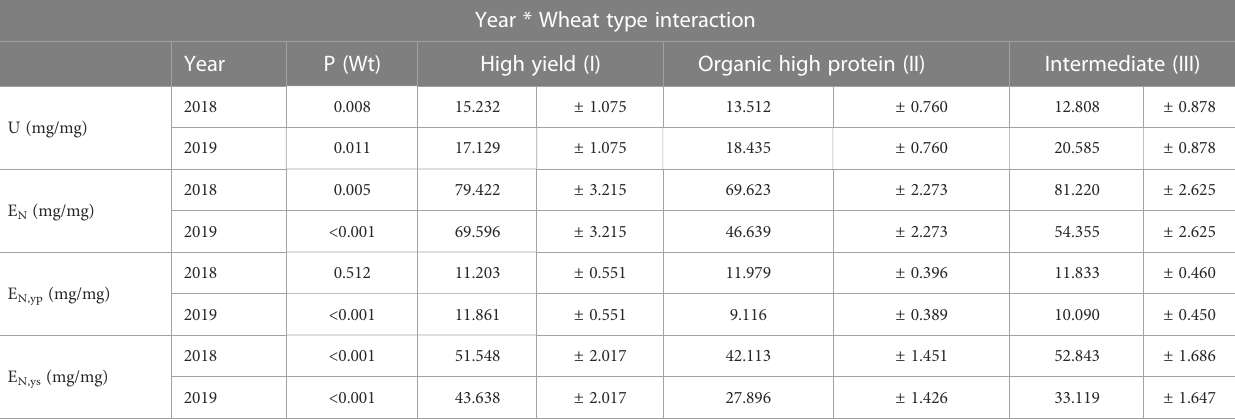
TABLE 6 Interaction between Year (2018 & 2019) and Wheat type (Wt; High yield (I), Organic high protein (II), and Intermediate (III)) of nitrogen (N) accumulation ef fi ciency components: U N use ef fi ciency, E N Grain-speci fi c N ef fi ciency, E N,yp Protein-speci fi c N ef fi ciency and E N,ys Starch-speci fi c N ef fi